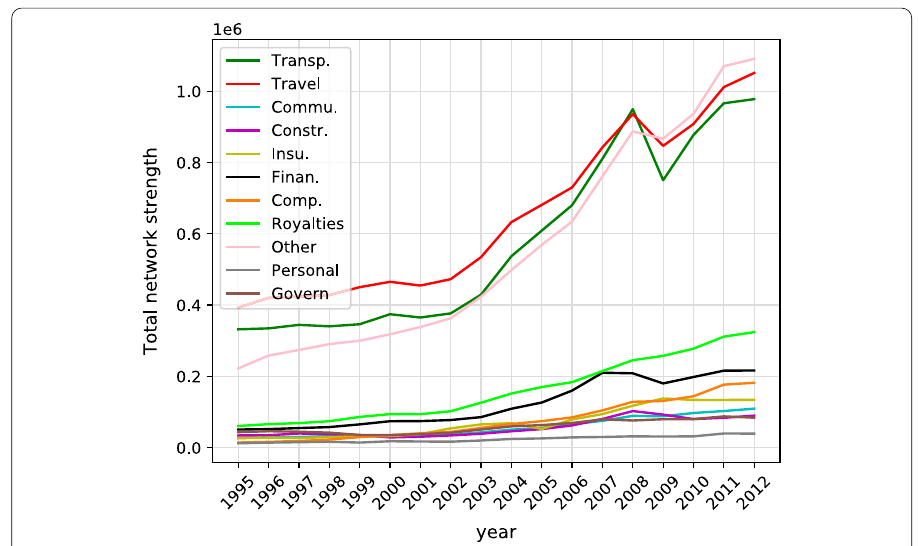
Fig. 1 Total world export (million US dollars) per service category during the analysed